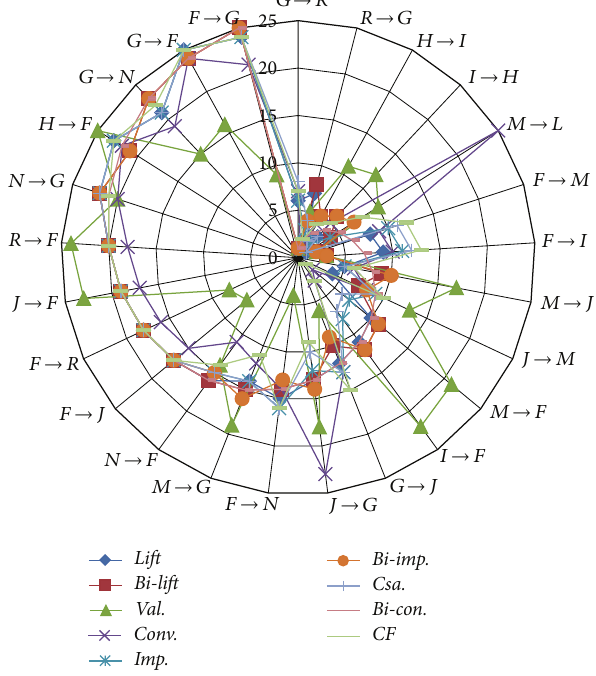
Figure 1: The radar map of evaluation results of measure methods.